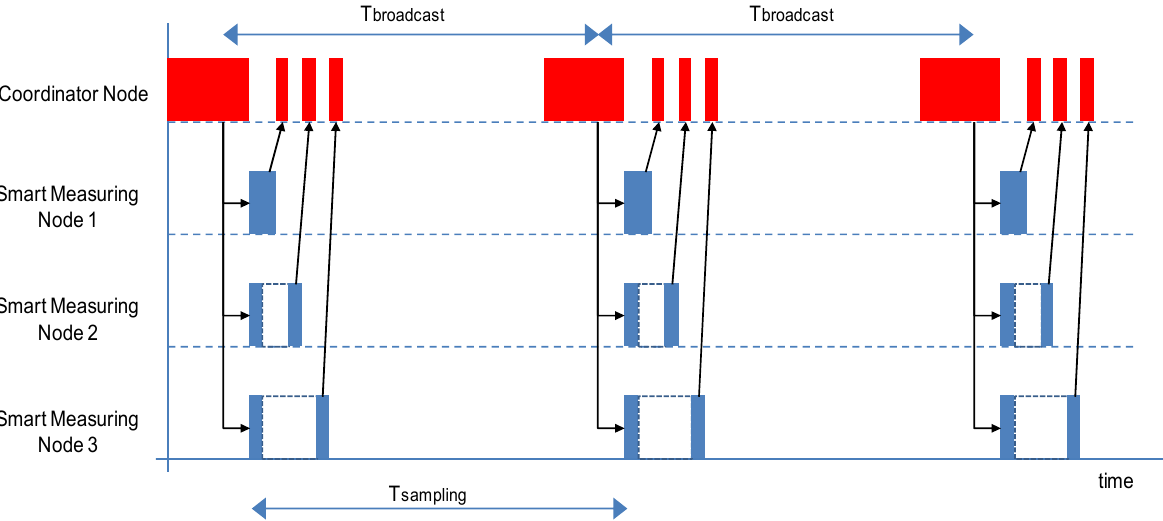
Figure 2. Chronogram for simple sampling distributed monitoring operation. Processing of the nodes and exchanged